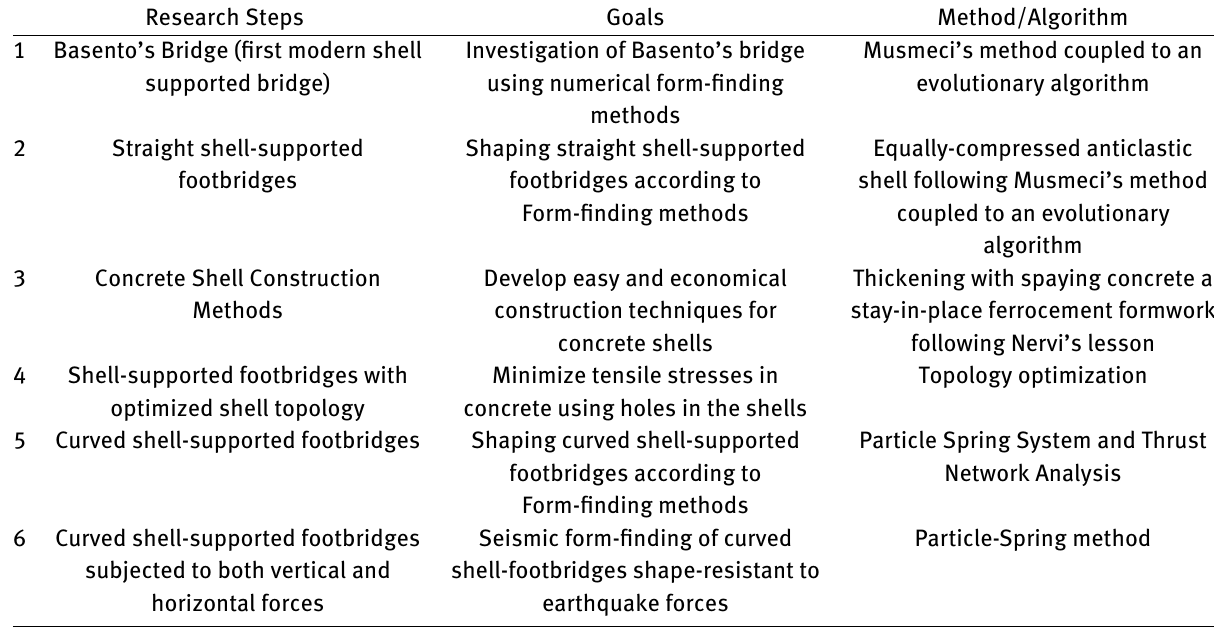
Table 1: Research steps on shell-supported footbridges with anticlastic equally-compressed shell Research